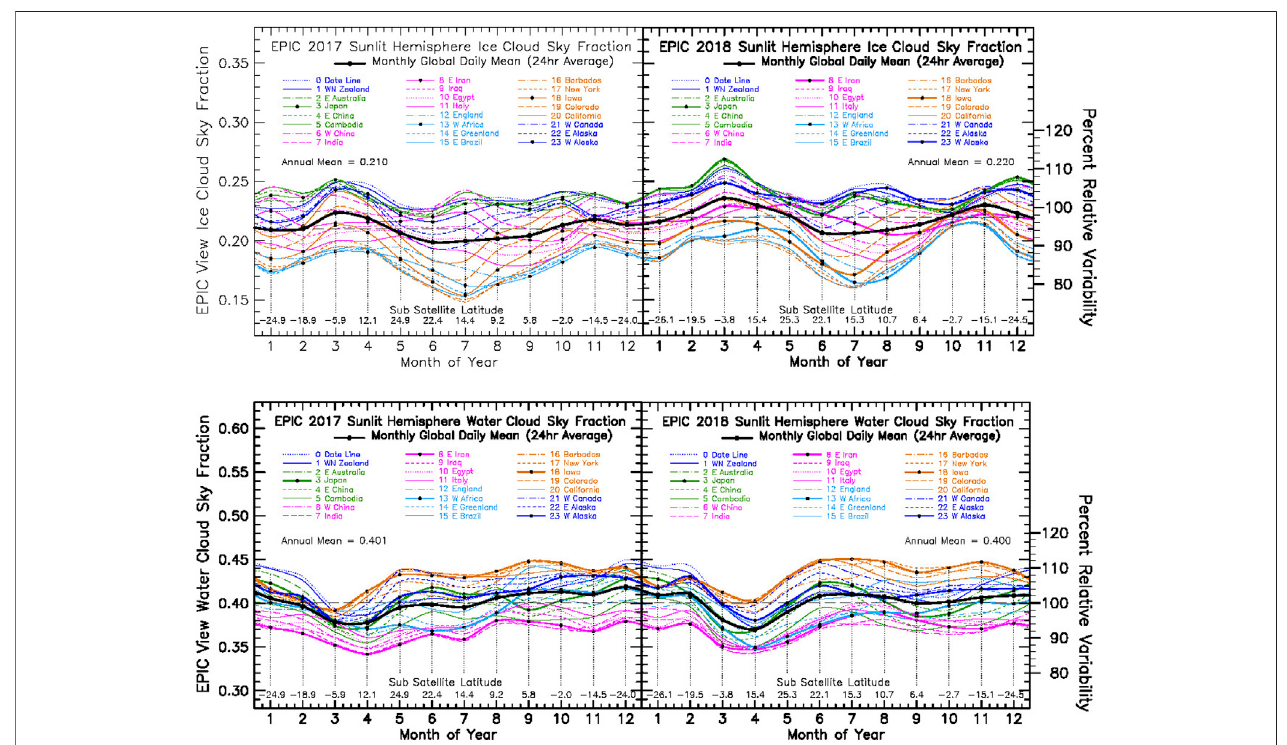
FIGURE 9 | Top Left : Ice cloud sky fraction from EPIC Composite analysis results for year 2017, and Top Right : ice cloud sky fraction for year 2018. Bottom Panel Left : Water cloud sky fraction from EPIC Composite analysis results for year 2017, and Bottom Right : water cloud sky fraction for 2018.